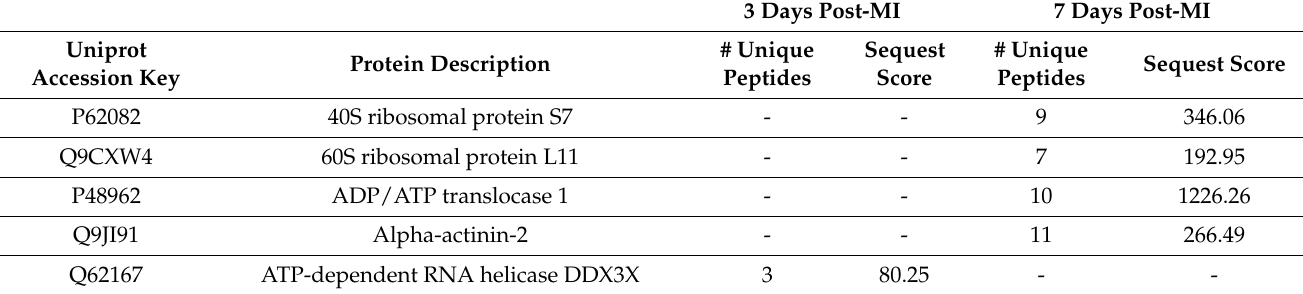
Table 1. Parameters of protein inference associated with the 46 differentially expressed proteins (DEPs) discussed in the manuscript. Confidence attributes, such as the number of unique peptides, and Sequest score pertaining to each protein are presented.